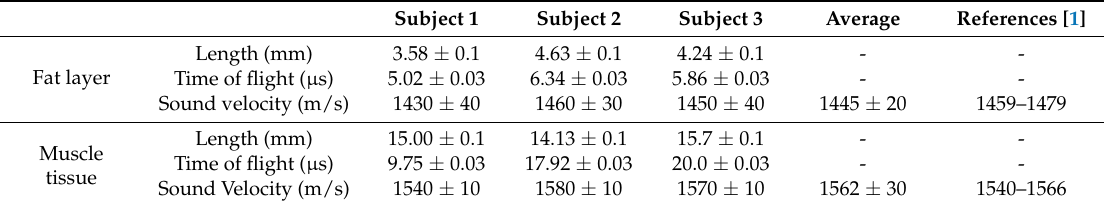
Table 5. The estimated values of sound velocity obtained by simultaneous US imaging and MRI.